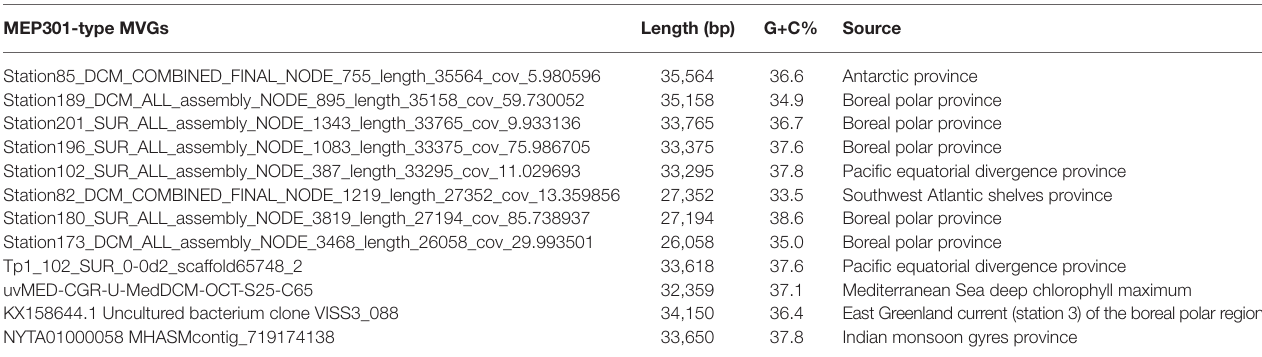
TABLE 1 | Genomic features of 12 nearly full-length MEP301-type